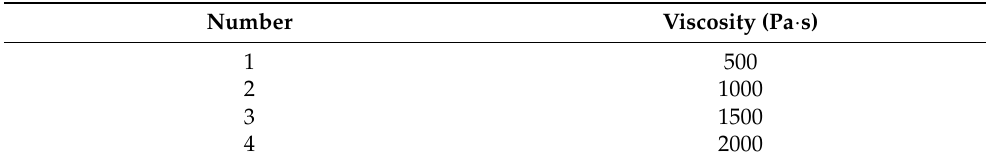
Table 2. The viscosity of dimethyl silicone